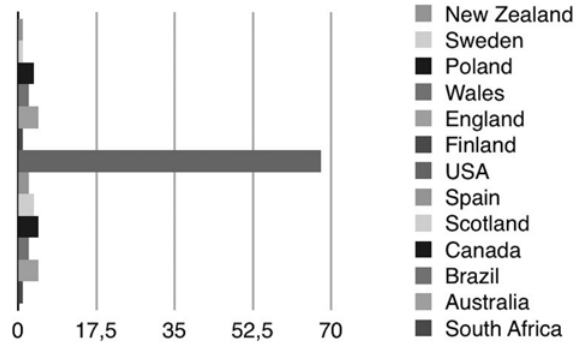
FIGURE 4 - Countries of publication of articles